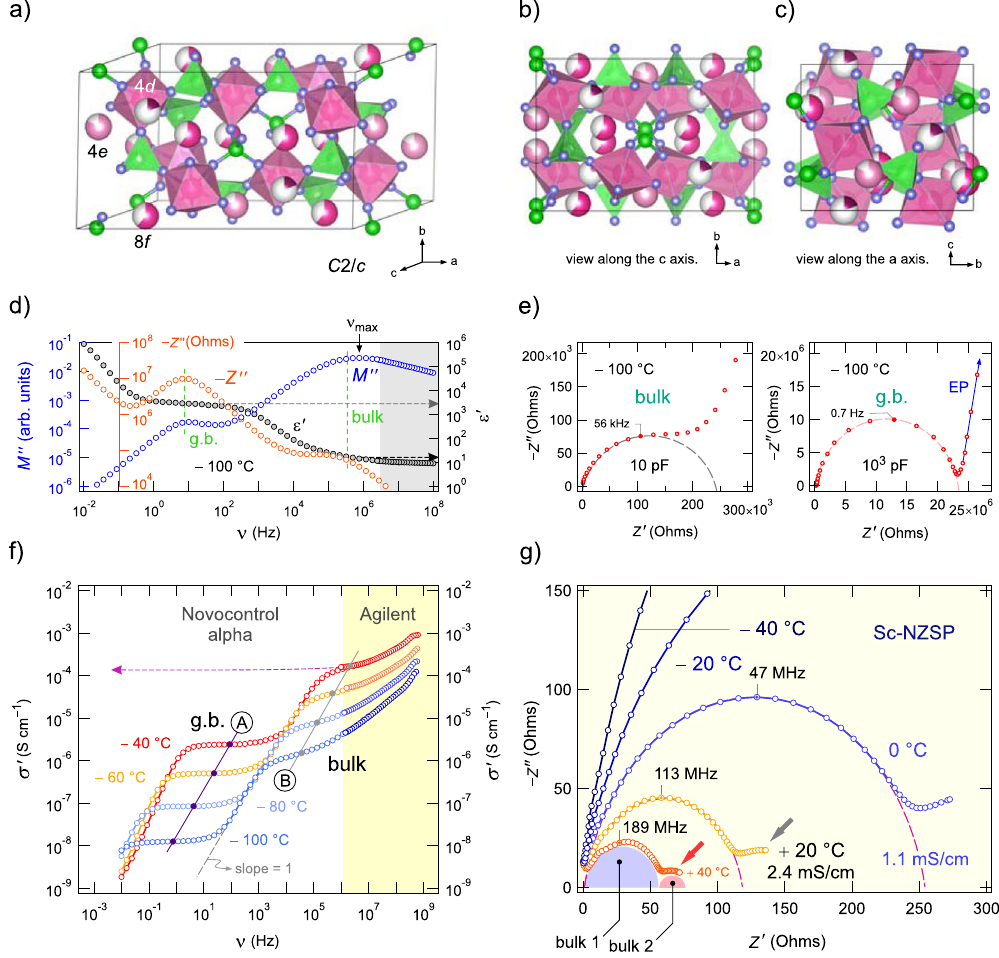
Figure 1. Crystal structure and conductivity. ( a–c ) Crystal structure of monoclinic Na 3 Zr 2 (SiO 4 ) 2 PO 4 . ( d ) Frequency dependence of the imaginary part of the complex impedance ( − Z ′′ ) and the complex modulus ( M ′′ ) of Sc-NZSP ( − 100 °C). For comparison, the variation of the real part ε ′ of the complex permittivity is also shown. − Z ′′ and M ′′ each reveal two maxima which correspond to the grain boundary (g.b., ε ′ = 3 × 10 3 ) and bulk response, respectively; the latter is seen in the high-frequency region, ε ′ ranges from 10 to 20. ( e ) Complex plane plots of the impedance data ( − 100 °C). The depressed semicircle at high frequencies (left) represents the (overall) bulk response ( C bulk = 10 pF). The g.b. contribution is characterized by C g.b. = 10 3 pF and a Debye-like non-depressed semicircle with its centre almost on the Z ′ axis (Fig. S1); piling up of the ions near the blocking electrode, i . e ., electrode polarization (EP), is seen as a spike at the lowest frequencies. ( f ) Conductivity isotherms of Sc-NZSP. The frequency independent regions (A) and (B) represent either the g.b. or the bulk response. The direct current g.b. response directly merges into a linear conductivity-frequency regime, σ ∝ ν (slope = 1). The arrow points to σ ′ in order of 10 − 4 S/cm at − 40 °C. ( g ) Nyquist plots recorded at frequencies greater than 10 6 Hz. At elevated temperatures the bulk response seems to be composed of at least two semicircles (bulk 1, bulk